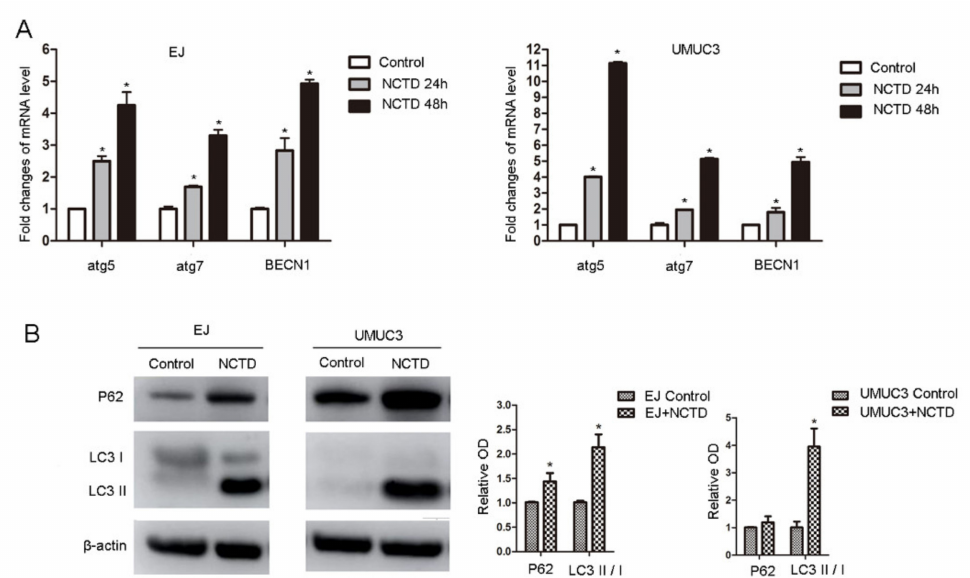
Figure 4. NCTD promotes bladder cancer cell autophagy. ( A ) EJ and UMUC3 cells were treated with NCTD (12 µ M) for 24 h and 48 h, mRNA levels of atg5, atg7, and BECN1 were detected by real-time PCR. ( B ) EJ and UMUC3 cells were treated with NCTD (12 µ M) for 48 h, P62 and LC3 protein levels were evaluated by Western blotting, β -actin was used as an internal control and relative protein levels were measured. Data are presented as mean ± SD ( n = 3), * p < 0.05 vs. the control group.